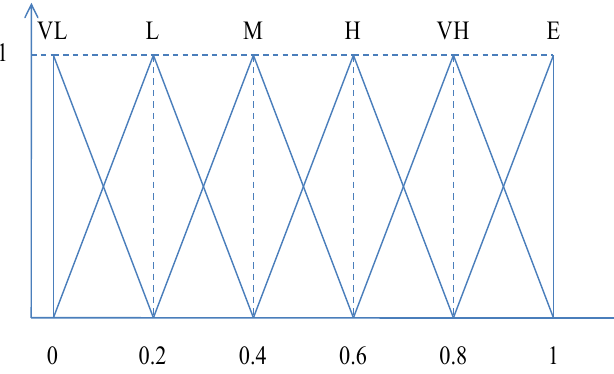
Figure 3. The membership